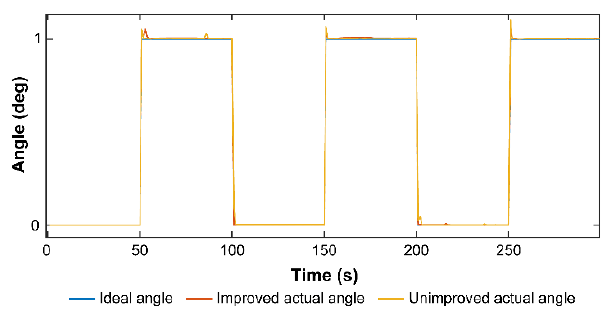
Figure 14. Pitch axis decoupling front and rear angular position tracking curve.